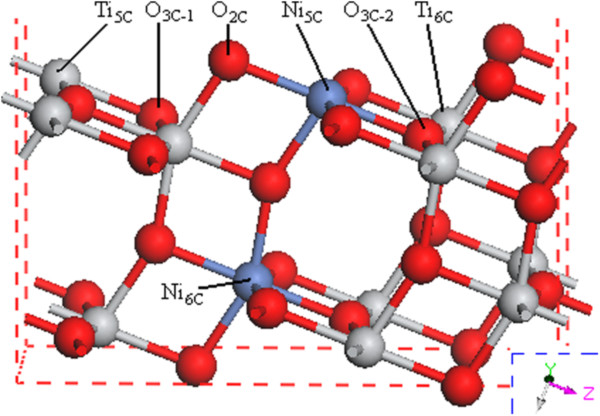
Atomic geometries of Ni-doped TiO2 (101) surface. The gray, red and blue balls represent O, Ti, and Ni atoms, respectively. O2C, O3C, Ti5C, Ti6C, Ni5C, and Ni6C mean the most probable sites for the adsorption.